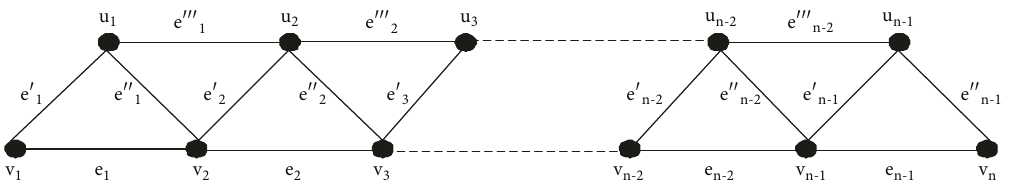
Figure 1: The total graph of path on n vertices.